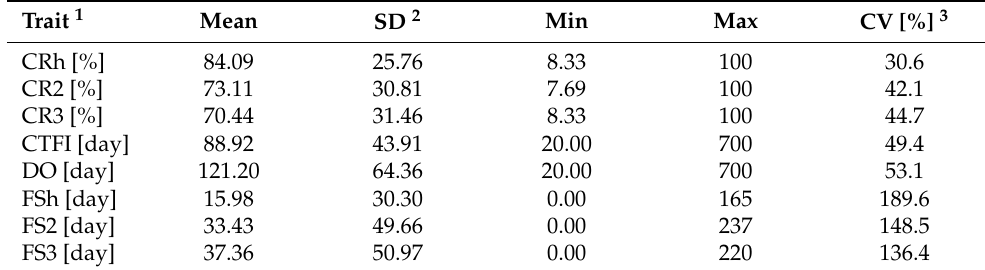
Table 2. Descriptive statistics of female fertility traits.